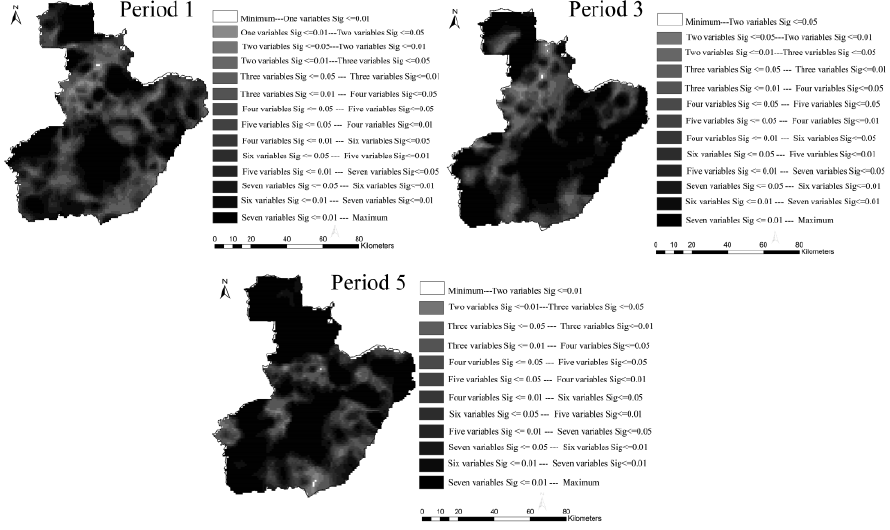
Figure 13. Number of variables with different significance levels for GTWR.